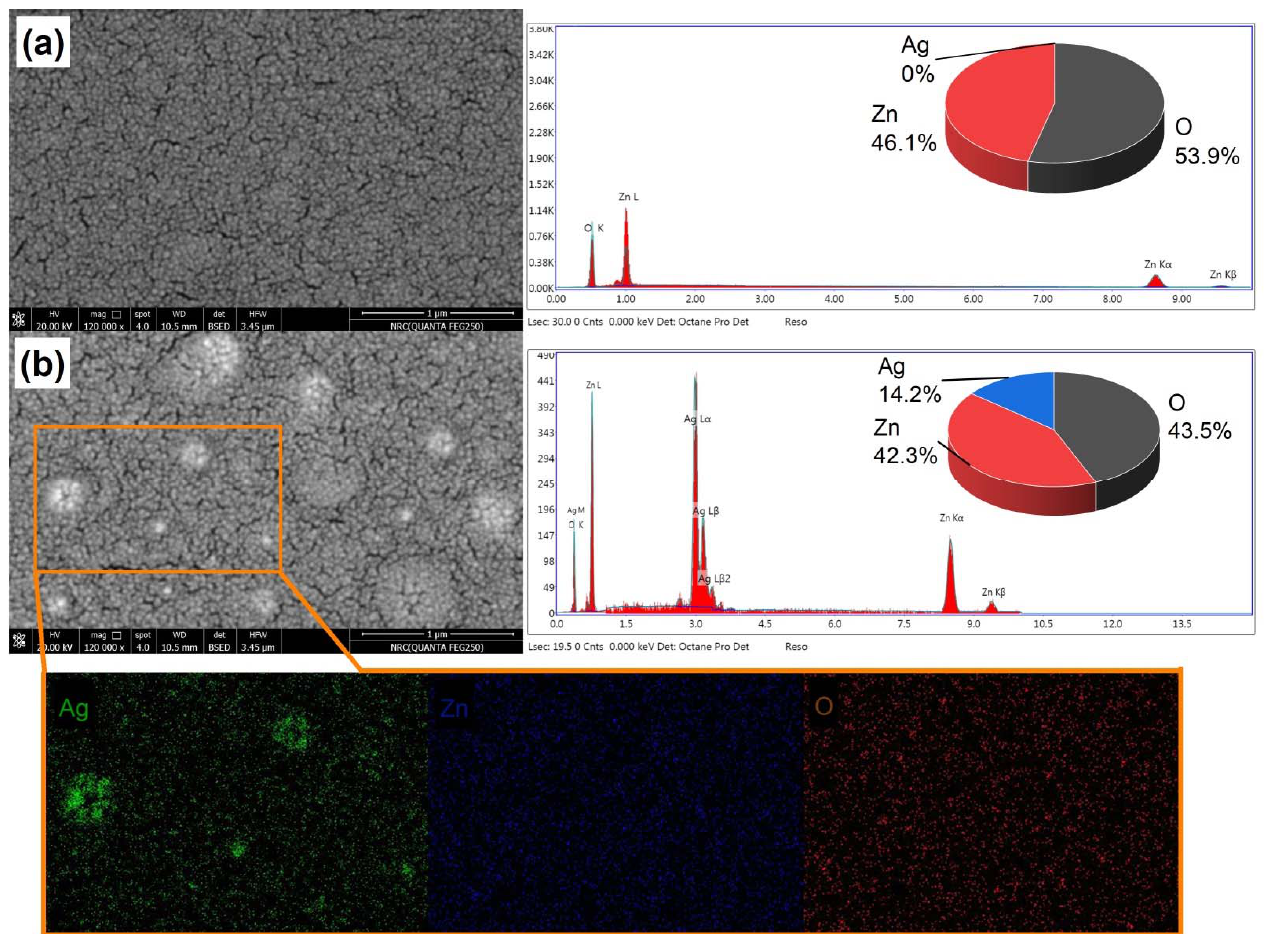
Figure 3. SEM image and elemental analysis of the prepared thin films of ( a ) ZnO and ( b ) Ag/ZnO . UV-vis spectrophotometer was used to evaluate the varying in the optical properties of the prepared strucuture. Figure 4 displays the UV-vis optical absorption spectra of ZnO and Ag/ZnO thin films. Strong excitonic peaks with significant absorbance strength are visible in the sample at 372 nm (pure ZnO). In addition, compared to pure ZnO, the absorption edge shifted to a longer wavelength with Ag deposition to create Ag/ZnO thin films. The inclusion of Ag into the ZnO matrix may be responsible for this shift in the absorption edge. Particles in doped ZnO may be smaller than the exciton Bohr radius, according to a shift in the absorption spectra [30–32]. This decrease in the transmittance values of the Ag/ZnO thin film in comparison to ZnO thin film may be caused by grain boundary scattering and the visible light absorption caused by surface plasmon reso- nance (SPR), which is in excellent agreement with previous studies in the literature [33,34].